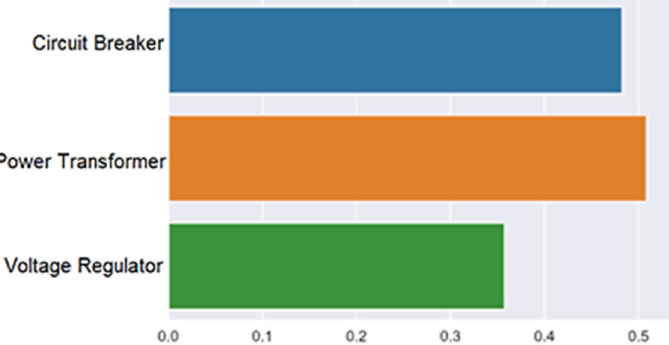
Figure 13. Average maintenance frequency predicted for 2019 [authors].